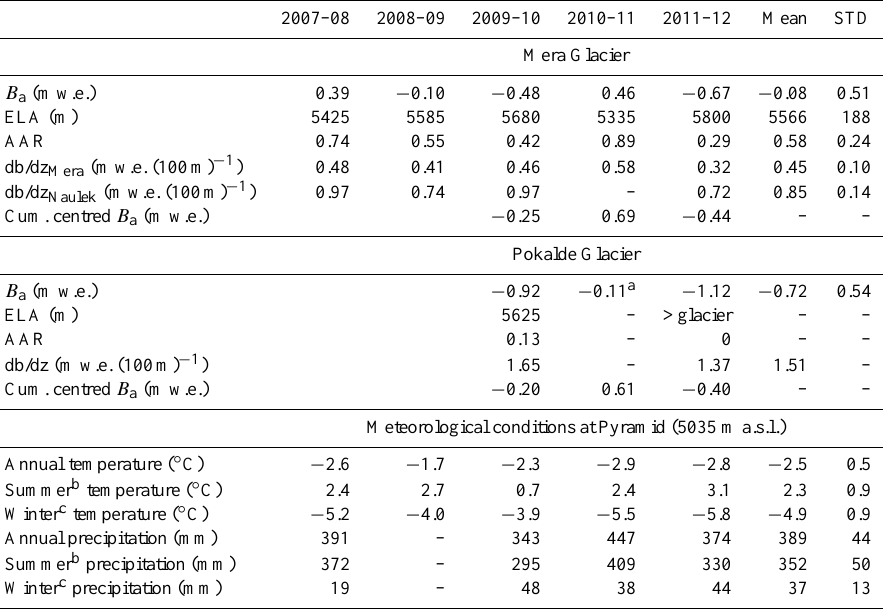
Table 2. Annual and 5yr mean glacier-wide mass balances B a , ELA, AAR and mass balance gradients db/dz for Mera and Pokalde glaciers, as well as some meteorological variables recorded at Pyramid Observatory (5035ma.s.l.). On Mera Glacier, mass balance gradients are distinguished between Mera and Naulek branches (referred as Mera and Naulek subscripts). The standard deviation (STD) is also displayed for every variable. The error range for B a is ± 0.28mw.e. Also shown is the cumulative centred mass balance (cum. centred B a = annual B a – mean value of B a over 2009–2012, the mean 2009–2012 value for Mera Glacier is − 0.23mw.e.yr − 1 ) . When there are data gaps, meteo- rological variables at Pyramid have been reconstructed at monthly time-step over the 2003–2012 period, applying a regression equation with the corresponding variable recorded at Pheriche (4260ma.s.l.) when available or otherwise at Namche Bazar (3570ma.s.l.). Precipitation data are missing in